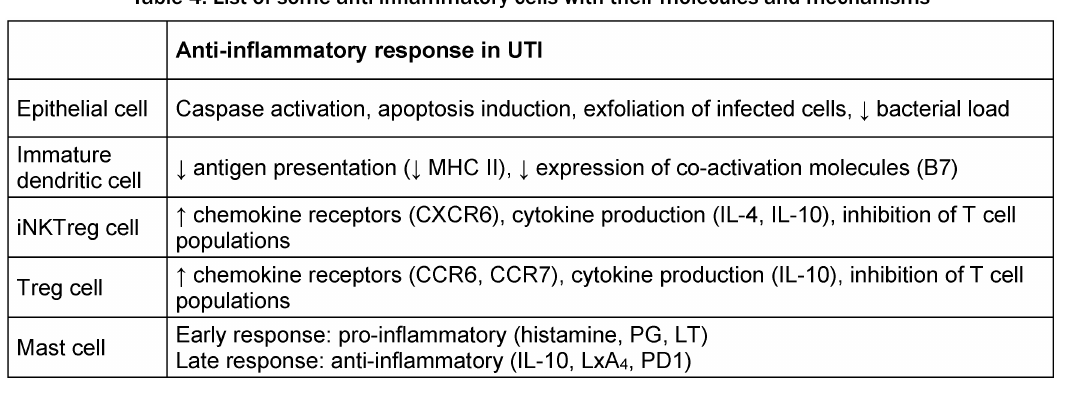
Table 4: List of some anti-inflammatory cells with their molecules and